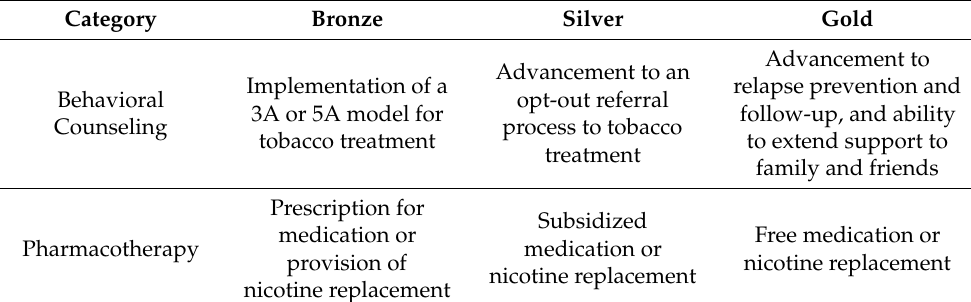
Table 1. Checklist used for jurisdictions’ self-assessment of behavioral counseling and pharmacother- apy implementation *. Category